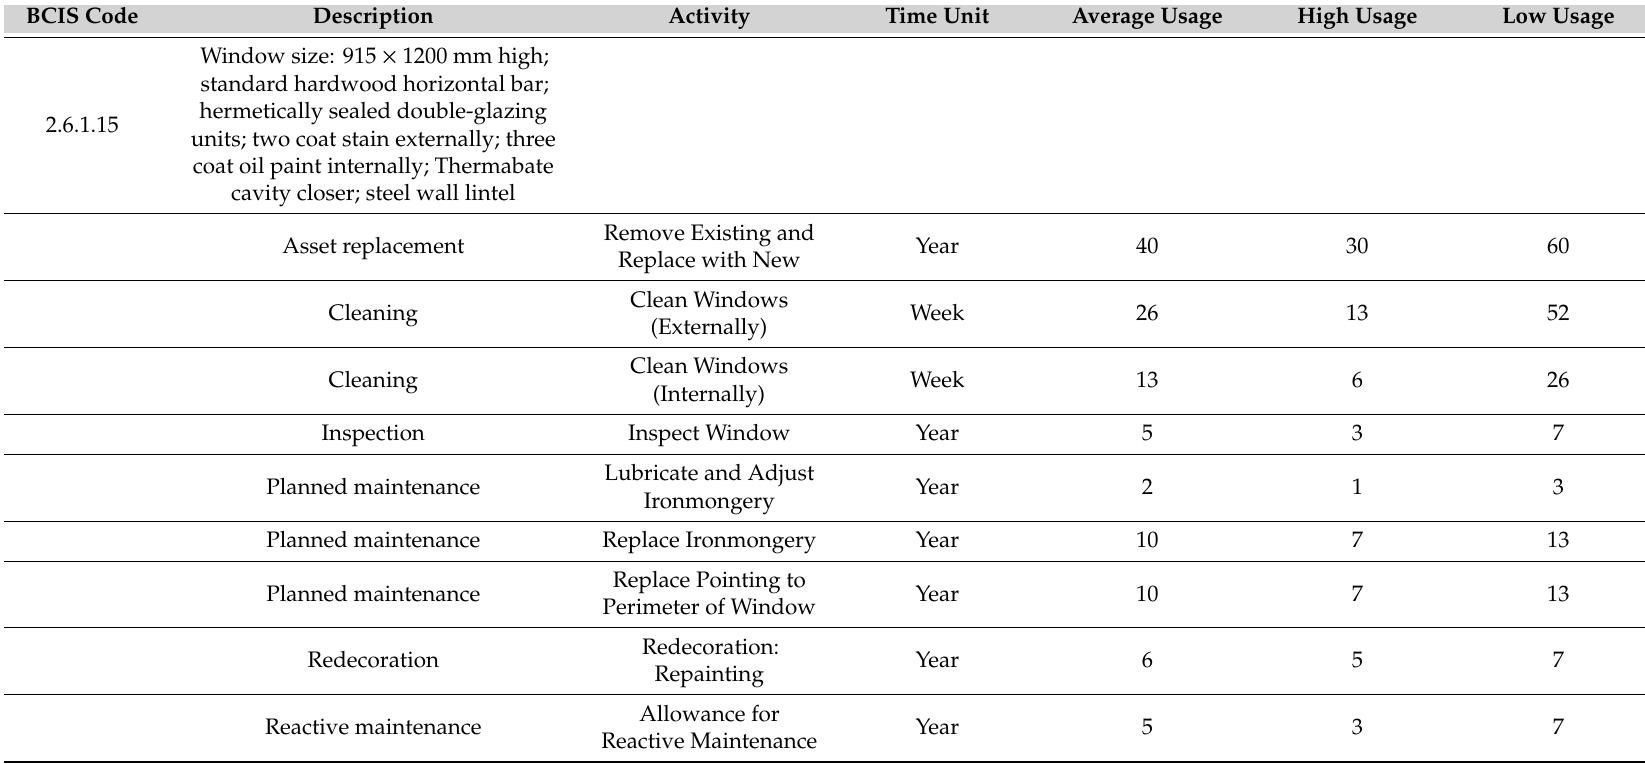
Table 1. Maintenance schedule example (source: RICS Building Running Costs